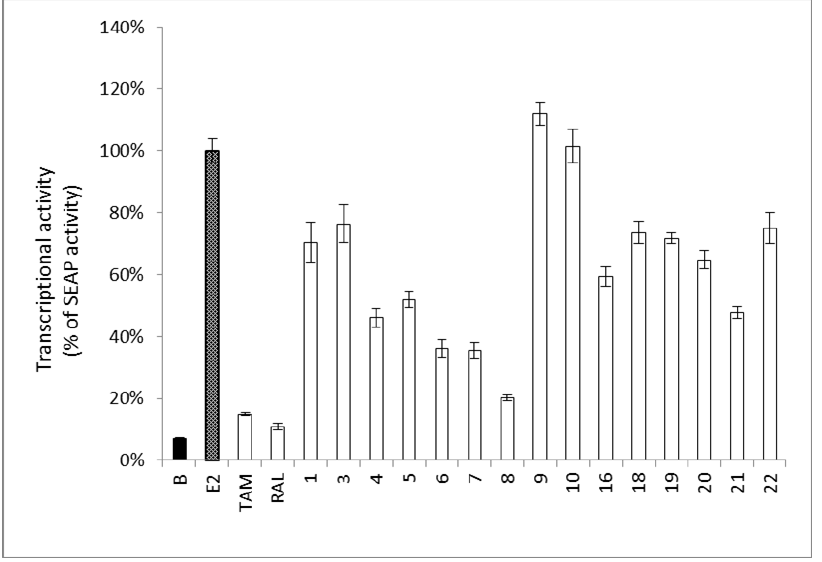
Figure 4. Antiestrogenic activity in MCF-7 cells of pure components from F. macrophylla . The SEAP activity induced by E2 (0.1 nM) was set to 100%. Cells treated with E2 (0.1 nM) and tamoxifen (TAM, 2 μM) or raloxifene (RAL, 20 nM), were selected as positive controls. Pure compounds (10 μM) were treated in the presence of E2 (0.1 nM). Each column represents a percentage of SEAP activity and is expressed as mean ± SEM ( n =